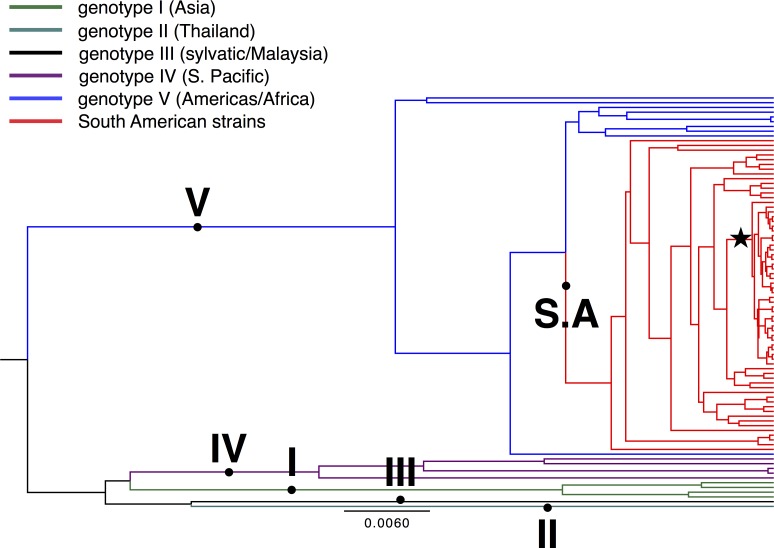
Genotyping of Colombian DENV-1 sequences based on E gene.Bayesian Maximum Clade Credibility tree of 87 DENV-1 E gene nucleotide sequences was reconstructed using a Markov Chain Monte Carlo (MCMC) approach as implemented by the program BEAST v1.8, under a HKY + Γ + Ι model and otherwise default parameters. Sequences representative of all five DENV-1 genotypes included. Only nodes (circles) with at least 60% posterior probability support are shown. Tree branches were transformed to cladogram for ease of visualization. Nodes representing the five DENV-1 genotypes are highlighted. Genotypes I-V are displayed by different color branches detailed in the legend. S.A stands for South American strains. The clade containing all strains sequenced in this study is marked by a star.